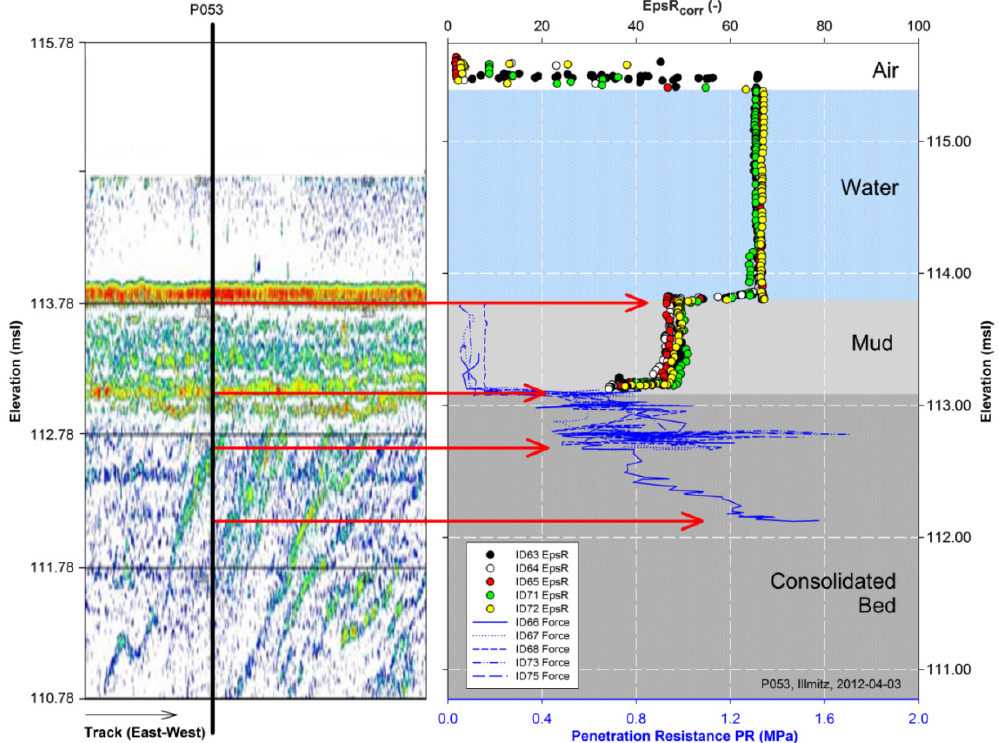
Figure 7. Example of preliminary layer validation by correlating the SBP echogram sequence ( Left ) including the validation-point P053 with the soil physical measurement system ( Right ). The layering in the echogram indicated by red-yellow, which visualizes strong reflections due to high impedance contrast, coincides reasonable well with the soil physically determined